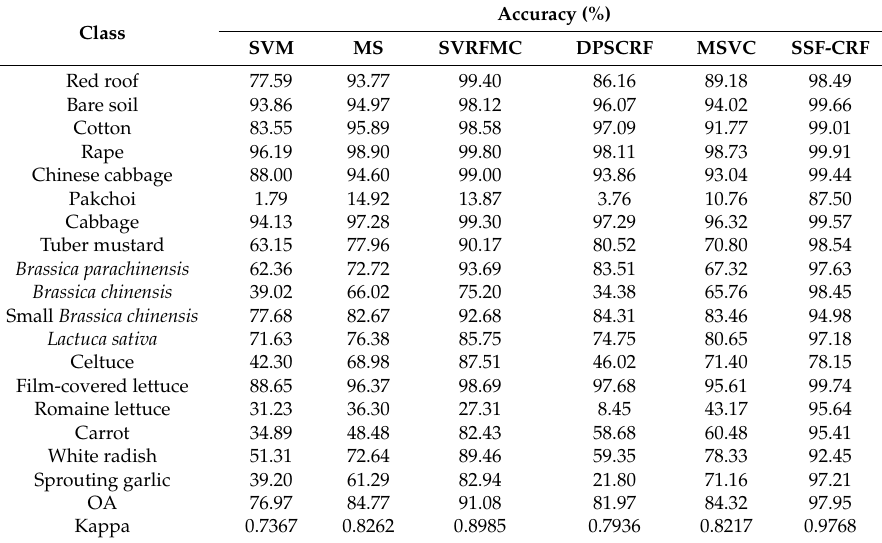
Table 5. The classification accuracies for the Honghu